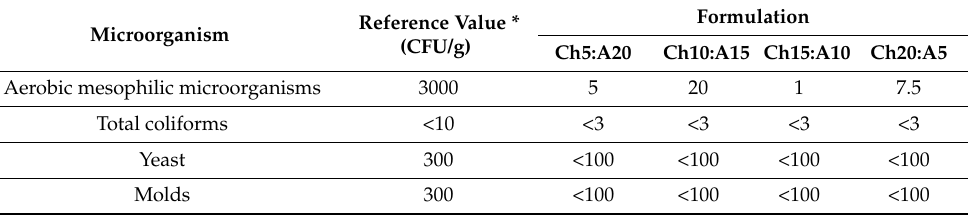
Table 4. Microbial count of mesophilic microorganisms, total coliforms, yeast, and molds of different formulation of cookies.